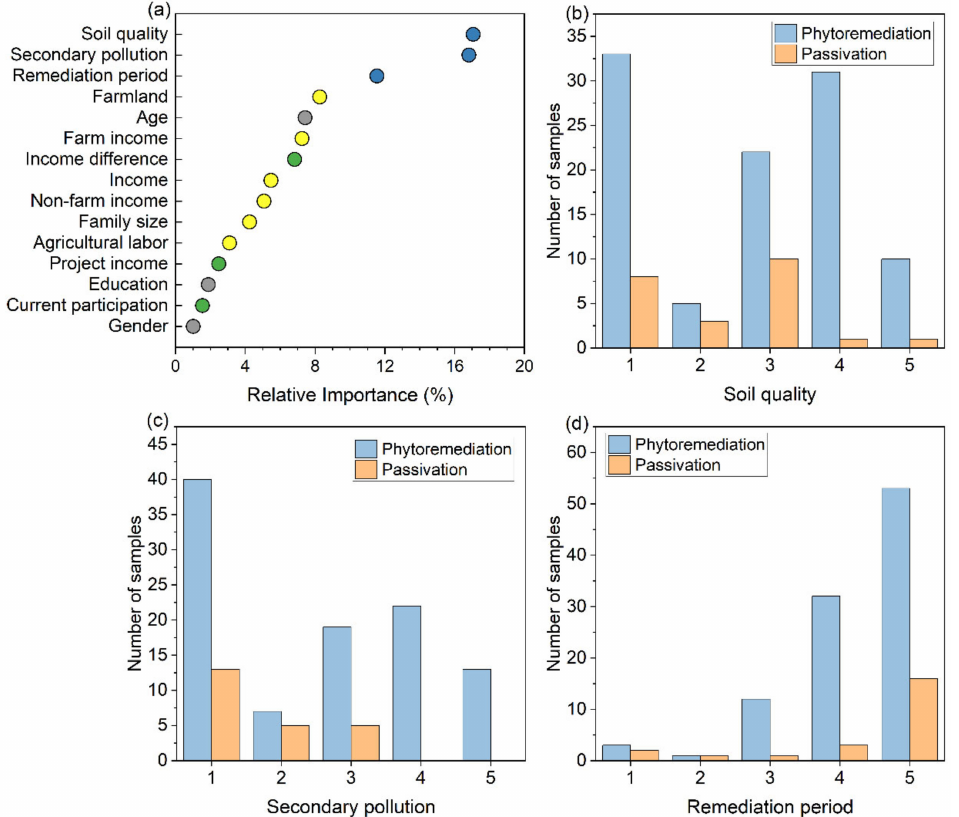
Figure 6. Factors influencing farmers’ technology preference. ( a ) The relative importance of the variables of farmers’ technology preference. Frequency distribution of respondents’ scores on ( b ) soil quality, ( c ) secondary pollution and ( d ) remediation period. Note: ( a ) was based on the results of the MeanDecreaseGini of the RF, and the sum of all factors was normalized to 100%. Then, the importance values of the independent variables were readjusted. The blue, yellow, green, and gray circles are technical characteristic variables, household characteristic variables, current participation variables, and personal characteristic variables, respectively. There were significant differences ( p < 0.05) in the scores of soil quality, secondary contamination, and remediation period between the sample farmers who chose phytoremediation and passivation after the Mann–Whitney U test (data not normally